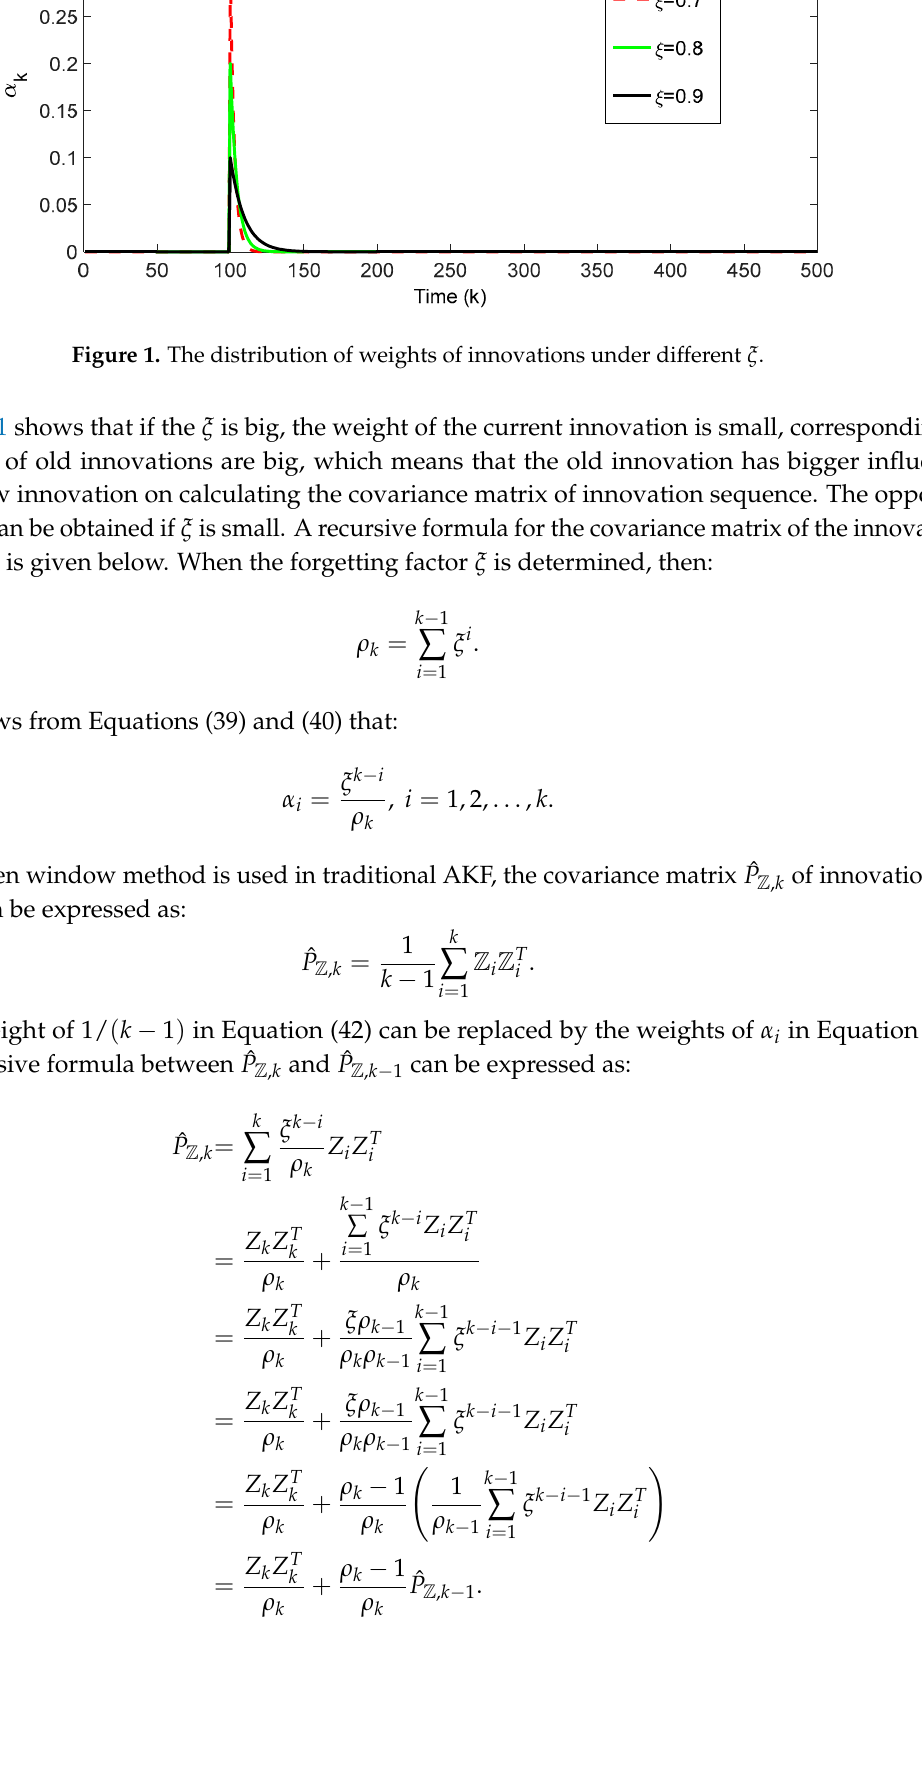
Figure 1. The distribution of weights of innovations under different